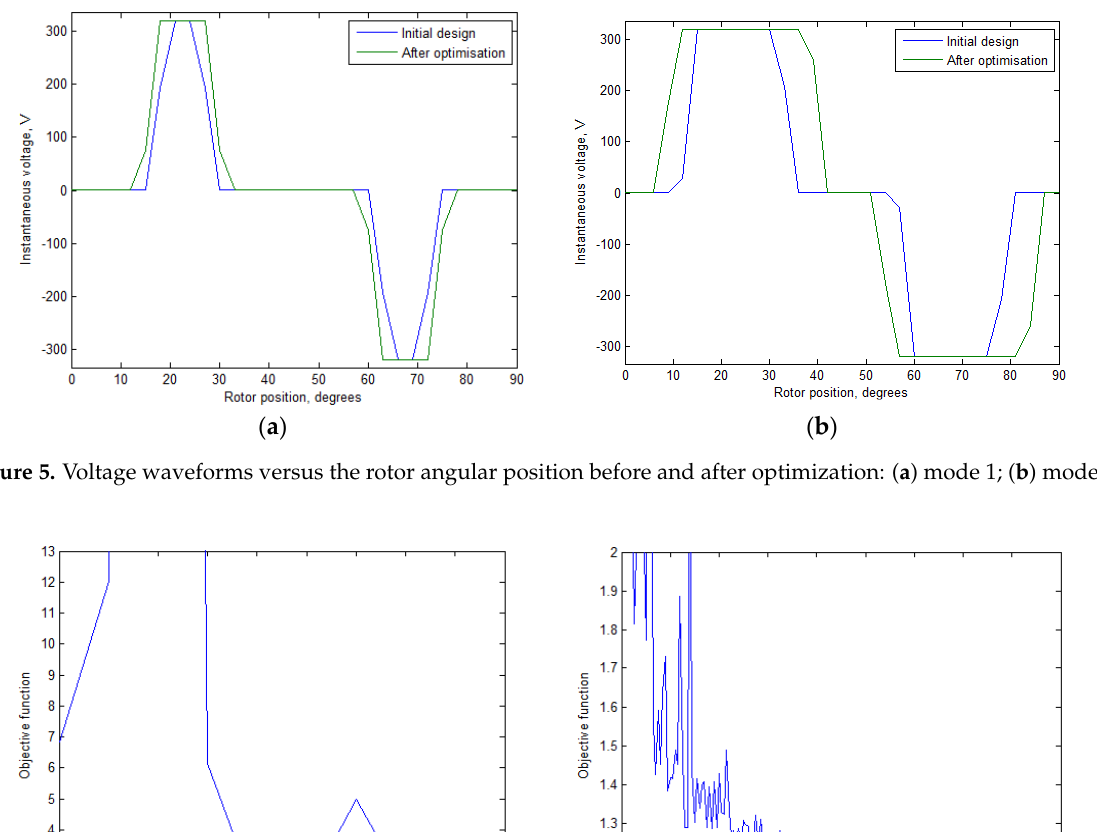
Figure 4. Current waveforms versus the rotor angular position before and after the optimization: ( a ) mode 1; ( b ) mode 2.